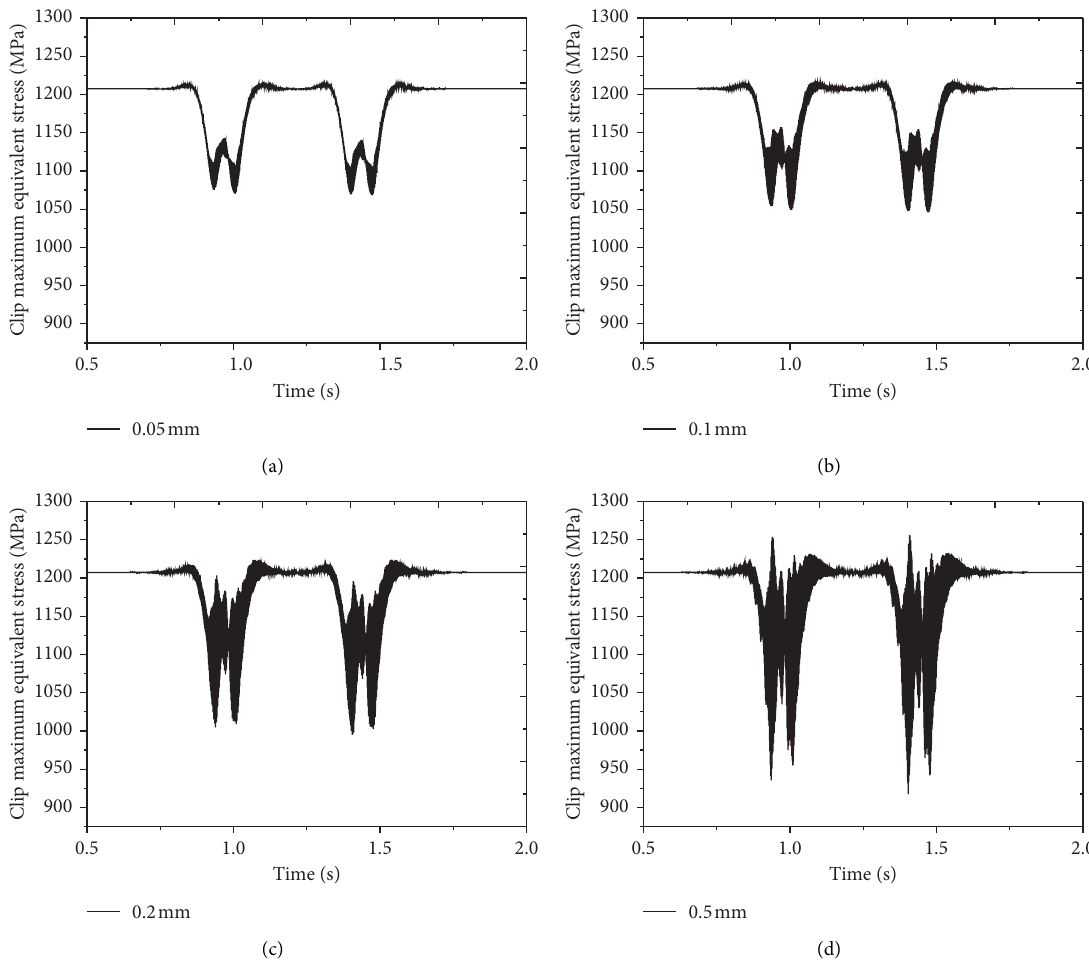
Figure 6: The maximum von Mises stress-time curve of elastic rail clip with a wavelength of 50mm at different rail corrugation amplitudes: (a) 0.05 mm;(b) 0.1 mm; (c) 0.2 mm;(d)